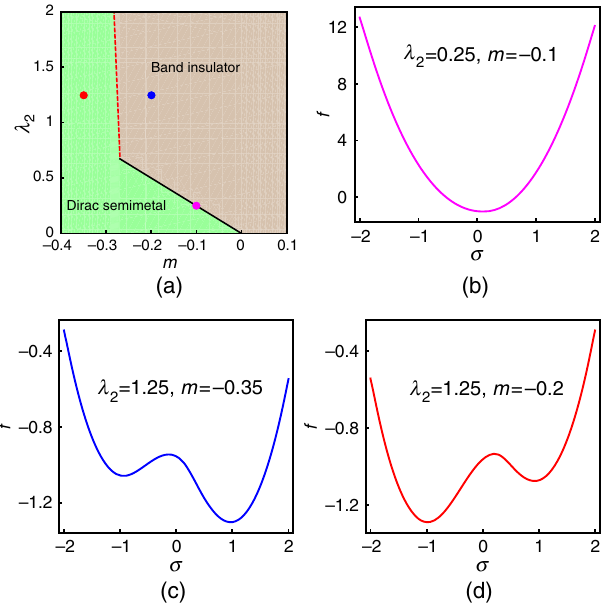
FIG. 5. (a) Phase diagram of interacting spinless fermions obtained by minimizing the free energy, shown in Eq. (22). The profile of the (dimensionless) free energy at three points in the phase diagram, marked in Fig. 5(a), is shown in panels (b) – (d). Values of various parameters are displayed in the corresponding figures. Here, λ 2 and m are the dimensionless interaction coupling and anisotropy parameter, and σ is the interaction-induced condensate of the anisotropy parameter (also dimensionless) [see Eq. (21)]. (b) For weak enough interaction, the free energy possesses only one global minimum and, thus, the direct transition between Dirac semimetal and band insulator is con- tinuous. The universality class of this transition is determined by the two-dimensional anisotropic semimetal. For stronger inter- action, the free-energy profile develops two inequivalent local minima, and, respectively, in panels (c) and (d), we display the free energy on the insulating and Dirac semimetal sides of the Fig. 5(a). transition. Consequently, the direct transition between these two phases at strong interaction becomes first order in nature [represented by the red dashed line in boundary between these two phases; this is represented by the solid black line in Fig. 5(a). interaction λ 2 > λ (cid:4) 2 ∼ 1 , the σ field acquires a finite vacuum